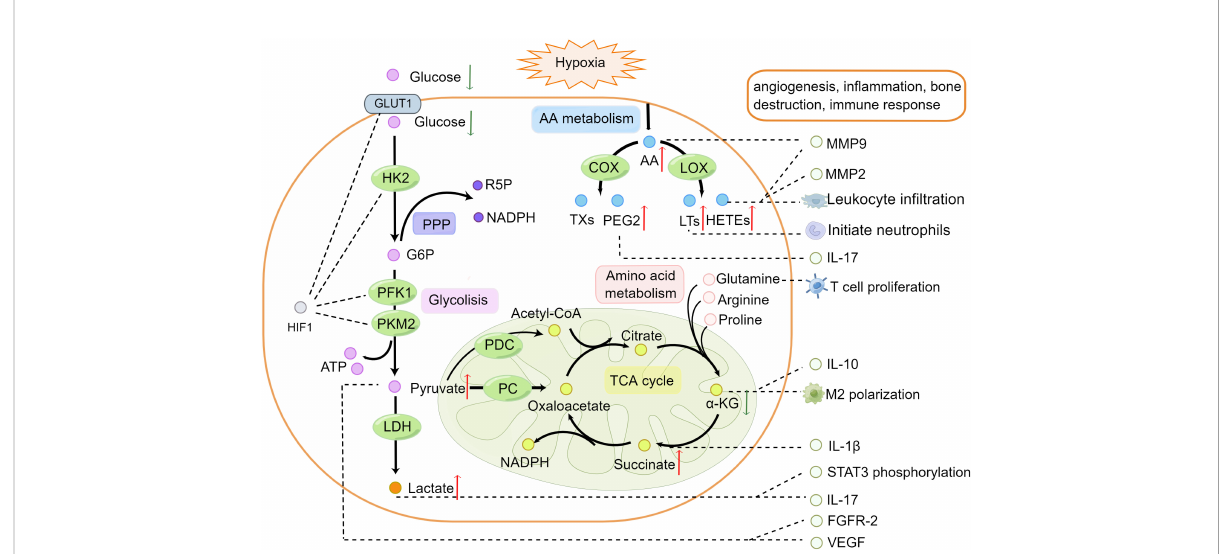
FIGURE 1 Alternations of metabolic pathways participate in the pathogenesis of rheumatoid arthritis. In the hypoxia microenvironment, HIF-1 a promotes the expression of glucose transporter 1 and activation of hexokinase 2, phosphofructokinase-1, and pyruvate kinase M2 in glycolysis. Glucose transported across the cell membranes by glucose transporter 1 then converted to pyruvate and generates two molecules of ATP. Glucose 6- phosphate from glycolysis enters the PPP to produce ribose 5-phosphate and nicotinamide adenine dinucleotide phosphate. Pyruvate is transformed into acetyl-coenzyme A and oxaloacetate and enters the TCA cycle in the mitochondria. AA can be derived from membrane phospholipids in hypoxia and in fl ammatory environments. AA oxidized to thromboxanes and prostaglandins such as prostaglandin E2 by cyclooxygenase, or leukotrienes and HETEs by lipoxygenase promotes leukocyte in fi ltration. Arginine, proline, and glutamine can be converted into a -ketoglutaric acid and participate in the TCA cycle. Metabolite changes in RA can promote cytokine secretion, increasing the expression of vascular endothelial growth factor, fi broblast growth factor receptor-2, MMP9, MMP2, and activated signal transducer and activator of transcription phosphorylation along with leukocyte in fi ltration. Red (up) arrow indicates up-regulated metabolites and green (down) arrow indicates down- regulated metabolites. The fi gure was drawn by using Figdraw. AA, Arachidonic acid; a -KG, a - Ketoglutarate; ATP, Adenosine Triphosphate; FGFR-2, Fibroblast Growth Factor Receptor 2; G6P, Glucose 6 Phosphatase; GLUT, Glucose Transporters; HIF-1, Hypoxia Inducible Factor-1; HK2, Hexokinase 2; IL-1 b , Interleukin-1 b ; IL-10, Interleukin-10; IL-17, Interleukin-17; LDHl, Lactate Dehydrogenase; LOX, lipoxygenase; LTs, Leukotrienes; MMP2, Matrix Metalloproteinases2; MMP9, Matrix Metalloproteinases9; NADPH, Nicotinamide Adenine Dinucleotide Phosphate; PC, pyruvate carboxylase; PDC, pyruvate dehydrogenase complex; PEG2, Prostaglandin E2; PFK1, Phosphofructokinase-1; PKM2, Pyruvate Kinase M2; PPP, Pentose Phosphate Pathway; R5P, ribulose 5-phosphate; STAT3, Signal Transducer and Activator of Transcription 3; TCA, Tricarboxylic Acid; TXs, Thromboxane; VEGF, Vascular Endothelial Growth